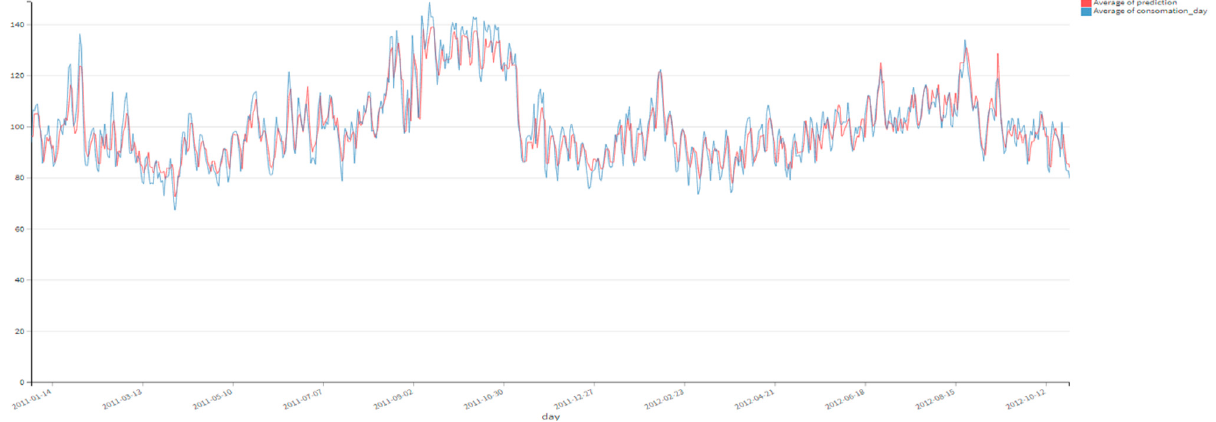
Figure 16. The tendency of real and predicted values.